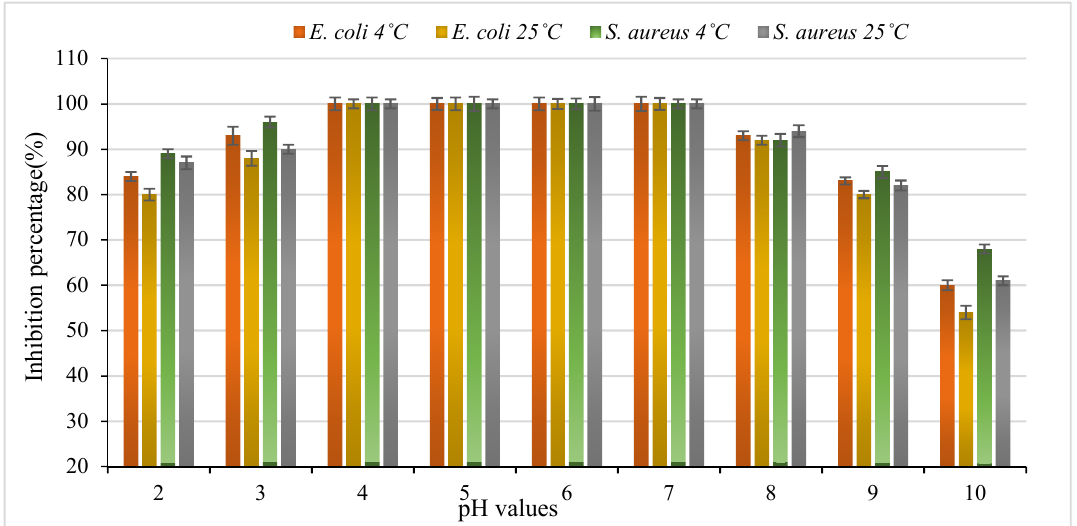
Figure 3. Stability of antibacterial peptide production from Saccharomyces cerevisiae under different pH and temperature conditions.